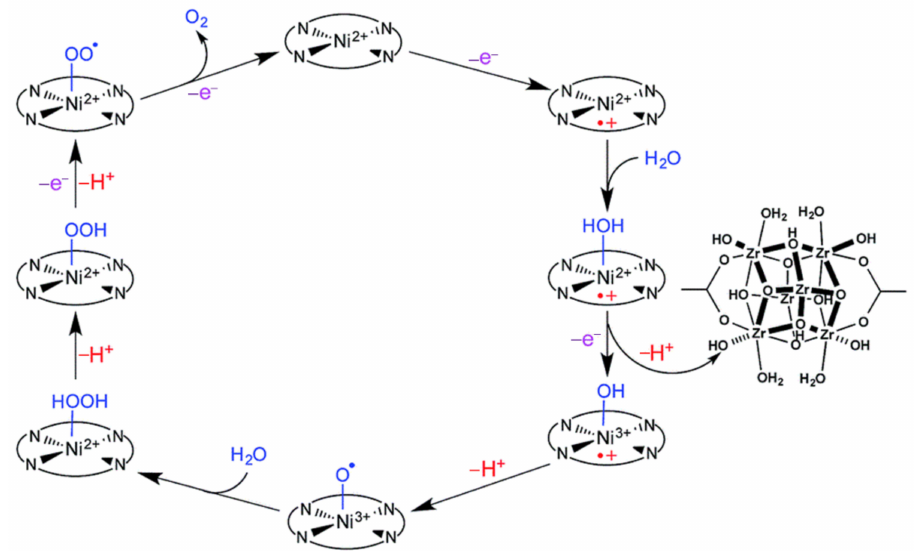
Figure 9. Proposed mechanism for the electrochemical OER catalyzed by PCN-224-Ni. Reprinted with permission from ref. [65]. Copyright The Royal Society of Chemistry